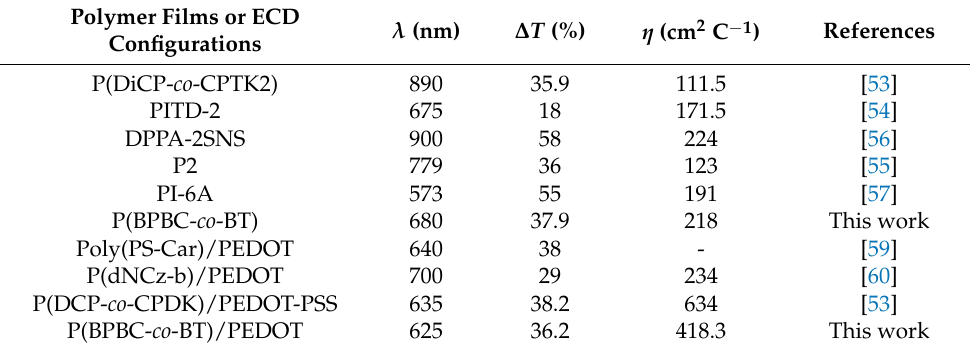
Table 4. Transmittance variations and η of polymers and